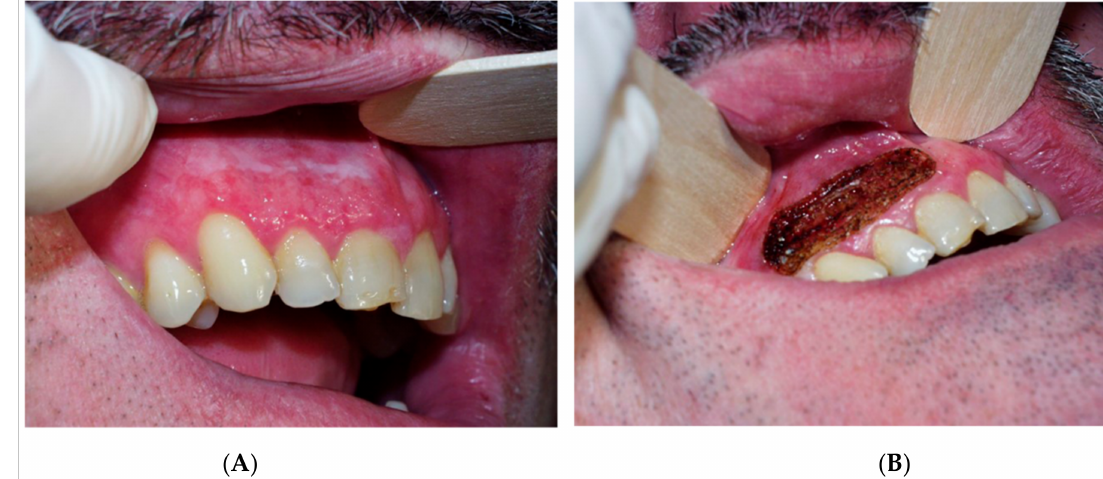
Figure 2. ( A ) Lesion before CO 2 . ( B ) Immediately after carbon dioxide surgery.